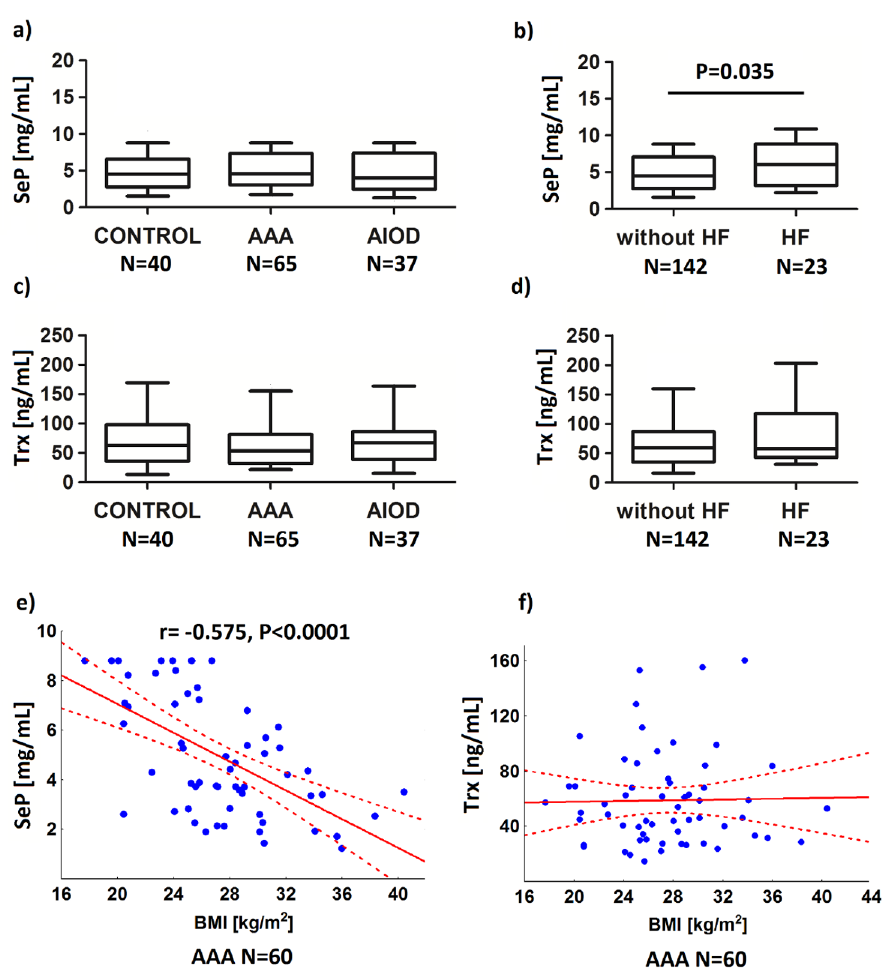
Fig 2. Relationships between plasma selenoprotein P (SeP) and thioredoxin (Trx) concentration and studied diseases (a-d), and BMI in the abdominal aortic aneurysm (AAA; e-f). Patients with AAA, patients with aortoiliac occlusive disease (AIOD) and the control group (CONTROL), as well as the AAA/AIOD patients classified into subgroups according to the presence of heart failure (HF) were analyzed.